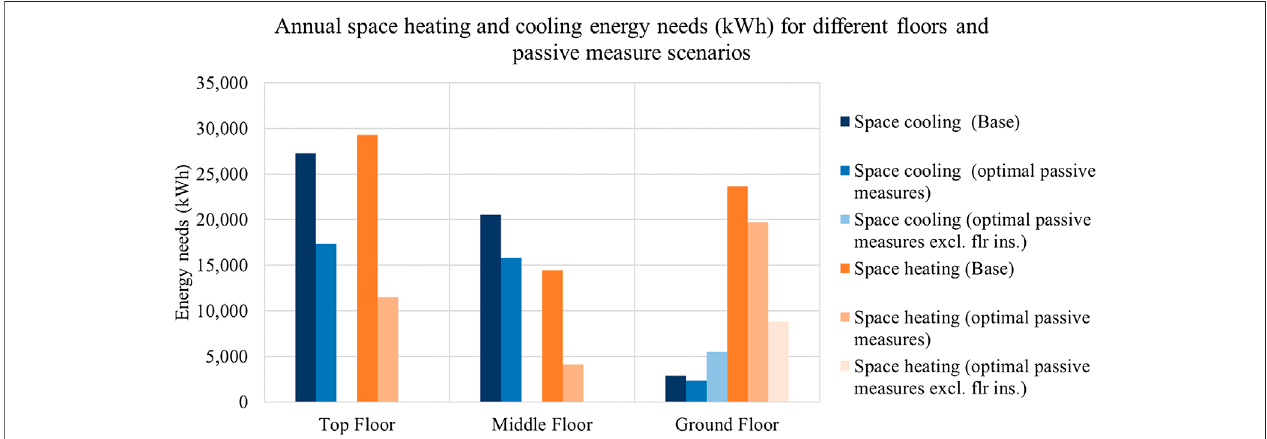
FIGURE 7 | Annual cooling and heating load energy needs (kWh) analysis for the base vs. the proposed passive measures scenarios grouped by fl oor level.